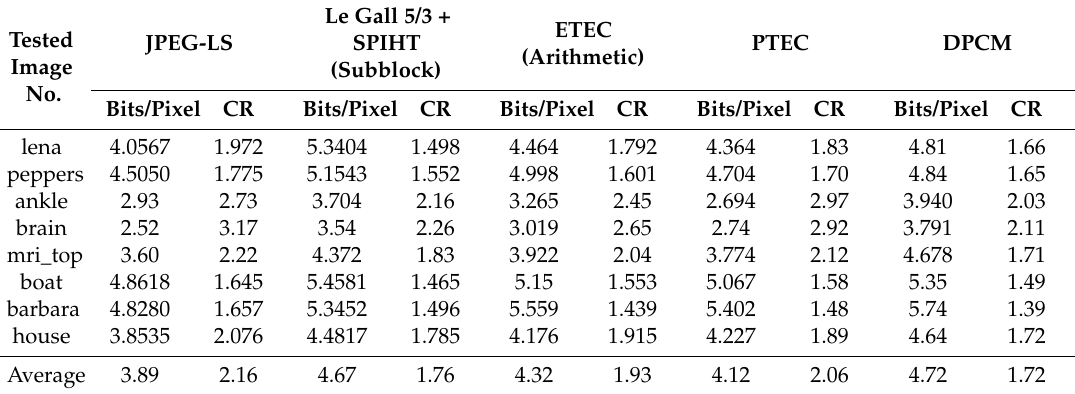
Table 4. Comparison of bits per pixel and compression ratio for non-pixelated images.